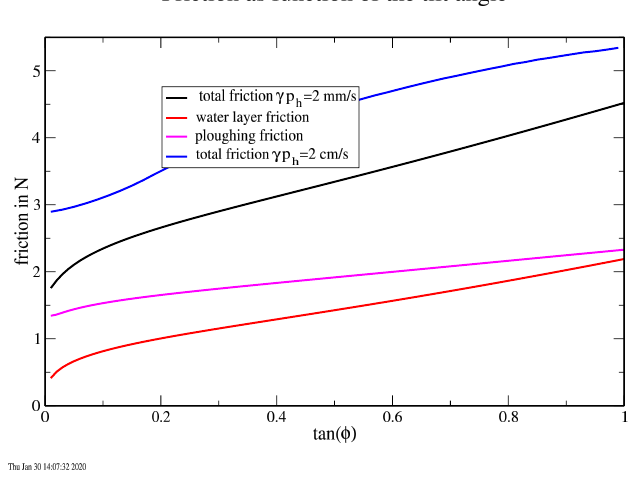
Figure 5: The friction contributions as function of the tilt